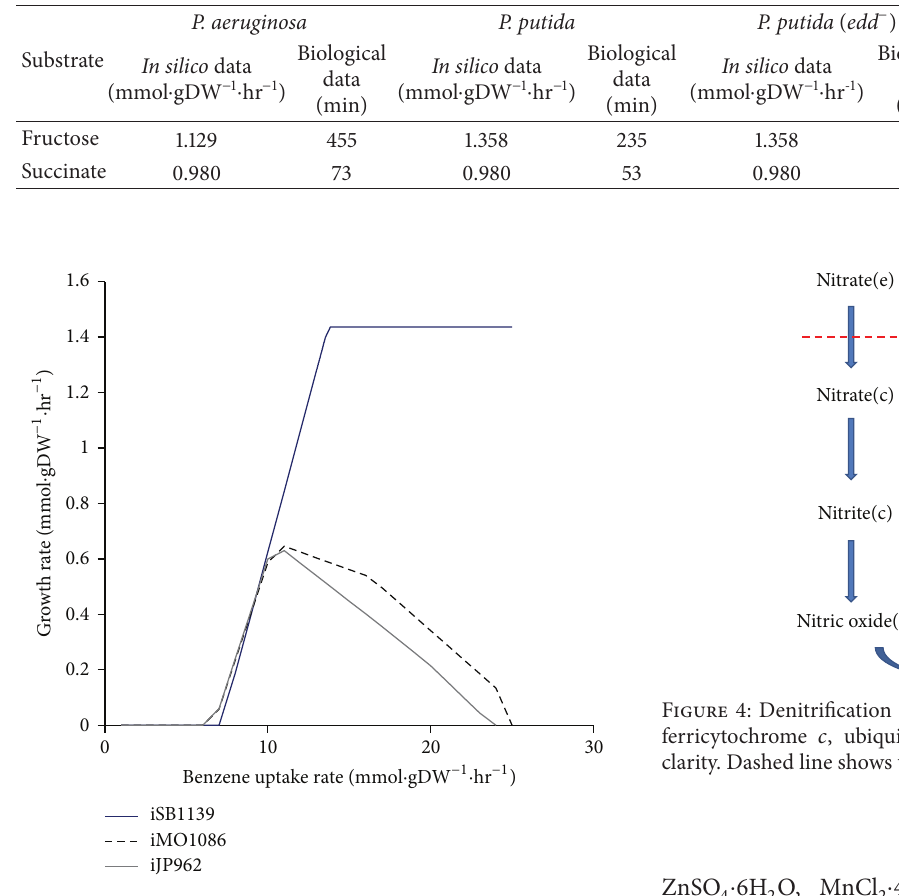
Figure 3: In silico modeling of Pseudomonas species growth on benzoate in MSM medium with a fixed oxygen uptake flux of 50 mmol ⋅ gDW −1 ⋅ hr −1 . Growth inhibition by high uptake fluxes of benzoate is seen in iMO1086 and iJP962. However, for iSB1139, the growth rate did not decrease, even at high benzene concentrations.